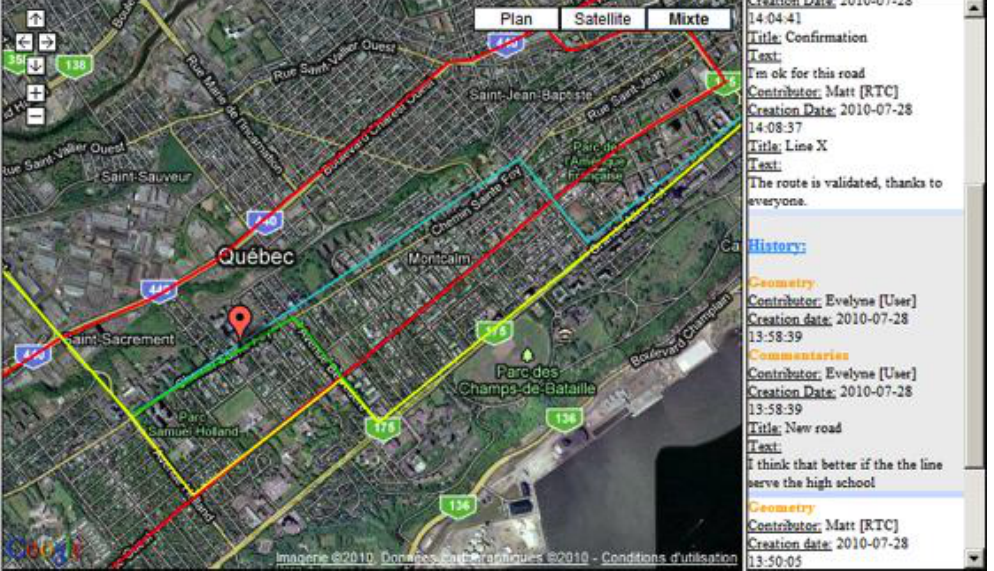
Figure 13. Visualization of the different routes with their associated